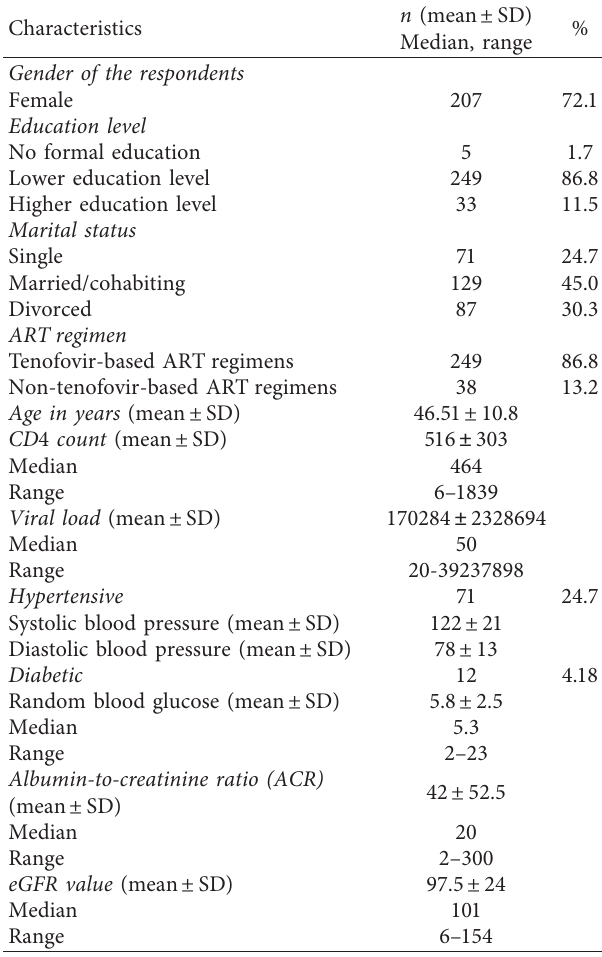
Table 1: Demographic and clinical characteristics of HIV patients on antiretroviral therapy at Muhimbili National Hospital ( N �